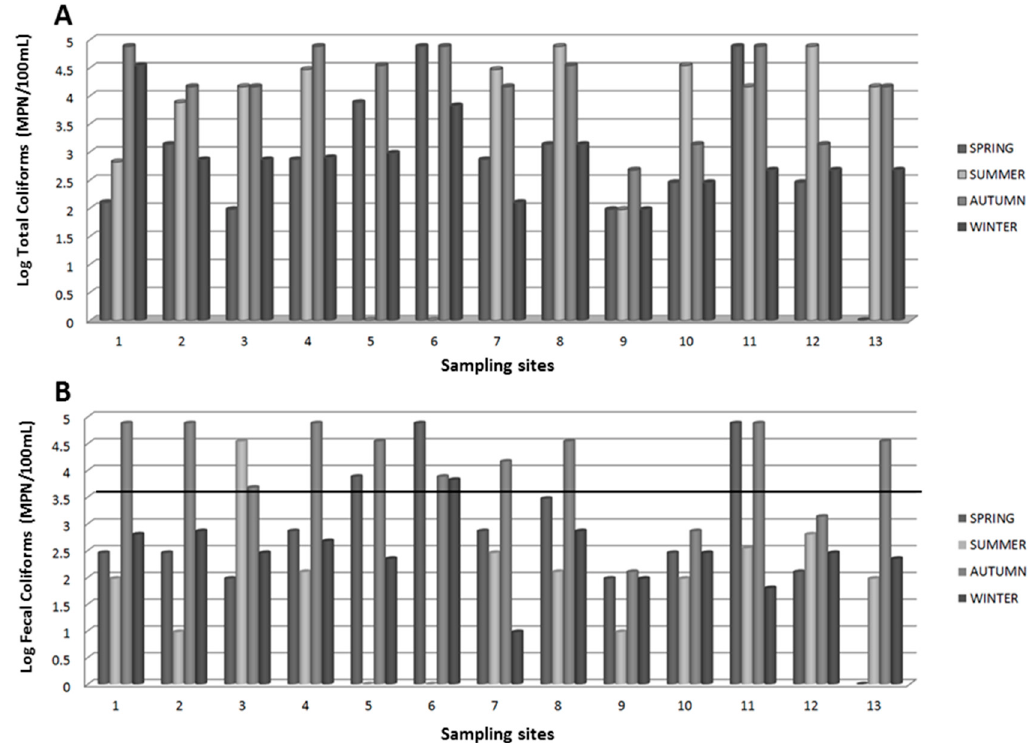
Figure 2. Log MPN counts of ( A ) total coliforms and ( B ) fecal coliforms per sampling site in the water samples collected from Bassaseachic Falls National Park, Ocampo, Chihuahua, México, during 2013. The black line across Figure 2B on 3.5 MPN indicates the [19]